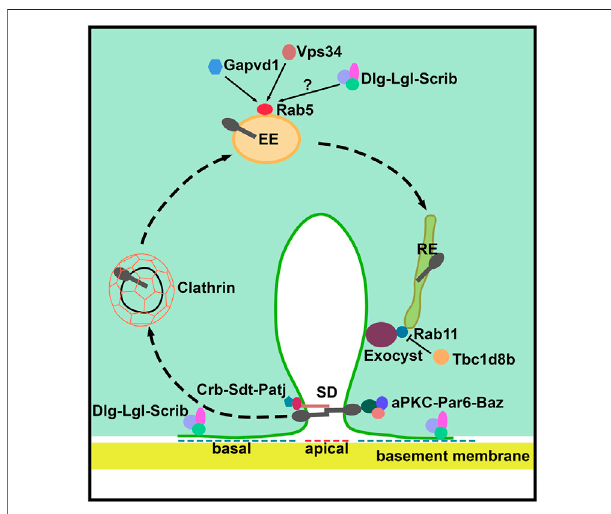
FIGURE 2 | Schematic of slit diaphragm formation and maintenance in Drosophila nephrocytes. The apical polarity Crumbs (Crb) and aPKC complexes are localized at the slit diaphragm and de fi ne the apical region of the nephrocyte which is important during slit diaphragm formation. The basolateral Scribble (Scrib) complex localizes to the basal region of the nephrocyte between neighboring slit diaphragms. The clathrin-mediated endocytosis, Rab5-dependent early endosomes, Rab11-dependent recycling endosomes and the exocyst complex are critical for slit diaphragm maintenance. Gapvd1, Vps34 (Pi3K59F), and possibly theScrib basalpolarity complex, positively regulate Rab5-dependent early endosome traf fi cking. Tbc1d8b negatively regulates the function of Rab11 in slit diaphragm recycling. SD, slit diaphragm; EE, early endosome; and, RE, recycling